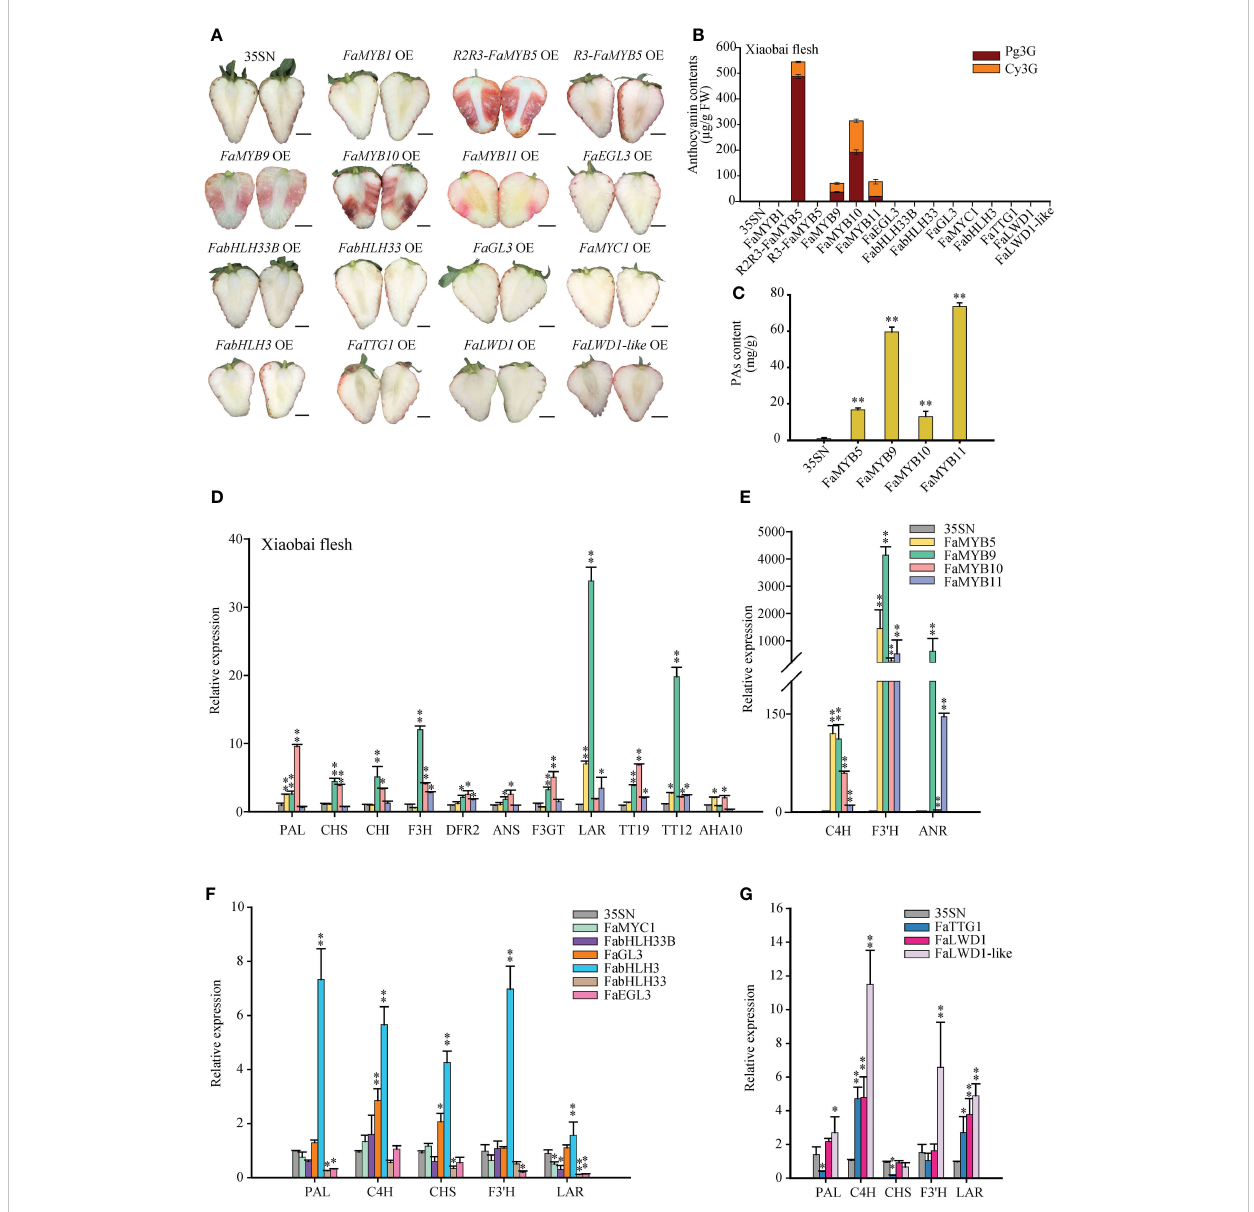
FIGURE 2 Effects of transient overexpression 15 TFs on anthocyanins and PAs in strawberry fruits. (A) The phenotype of transient overexpression 15 TFs in ‘ Xiaobai ’ fruits. OE, overexpressed sample; 35SN (empty vector) was as control, scale bars represent 10 mm. (B) Analysis of Cy3G and Pg3G by